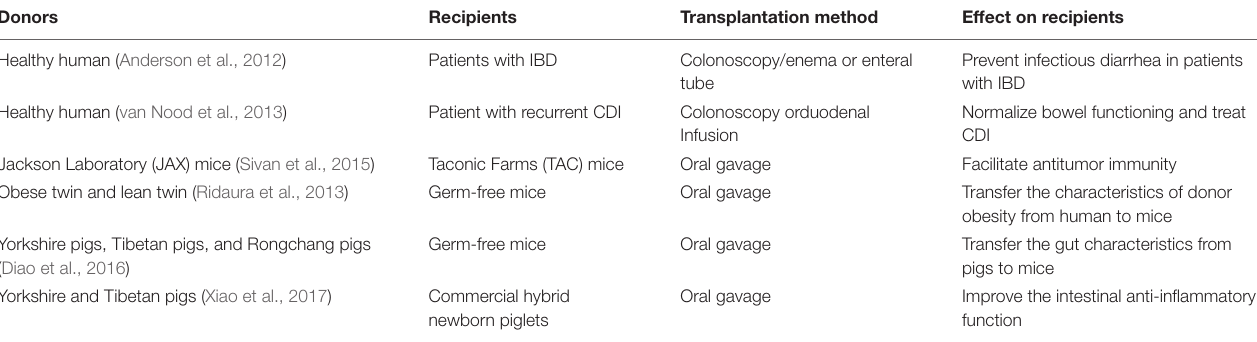
TABLE 1 | Characteristics of donors and recipients, transplantation method, and effect of FMT on